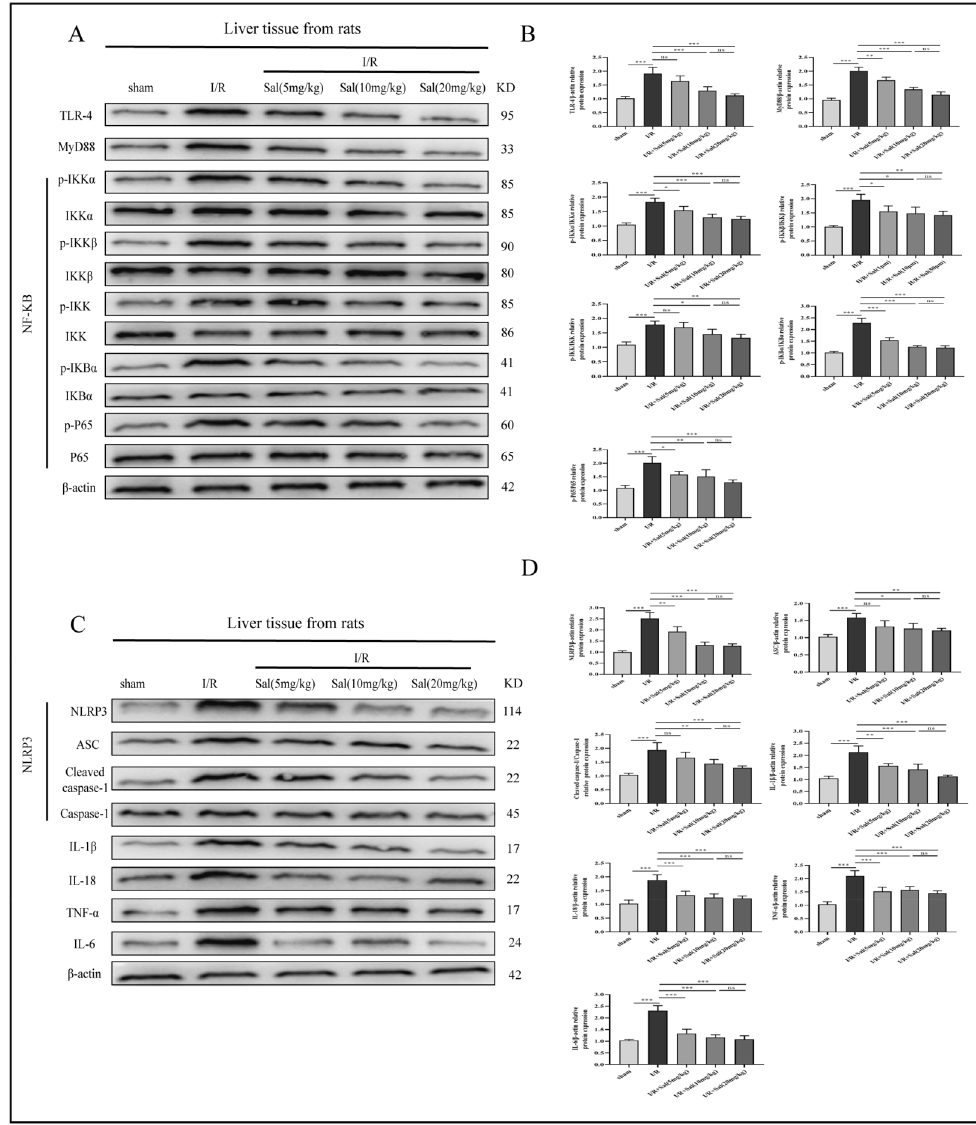
Figure 3. Salidroside inhibits TLR-4/NF-κB/NLRP3 inflammatory pathway in vivo. ( A , C ) Representative western blot assays showing TLR-4/NF-κB/NLRP3 inflammatory pathway associated proteins in the rat liver after liver transplantation. ( B , D ) Results of the Western blot experiments. The statistical differences among groups were assessed by one-way ANOVA. ns P > 0.05, * P < 0.05, ** P < 0.01, *** P <